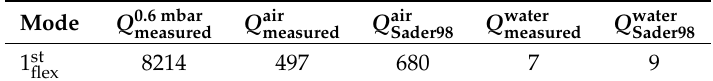
Table 2. Comparison between the experimentally measured and theoretical [19] quality factor of the NCLR cantilever in different